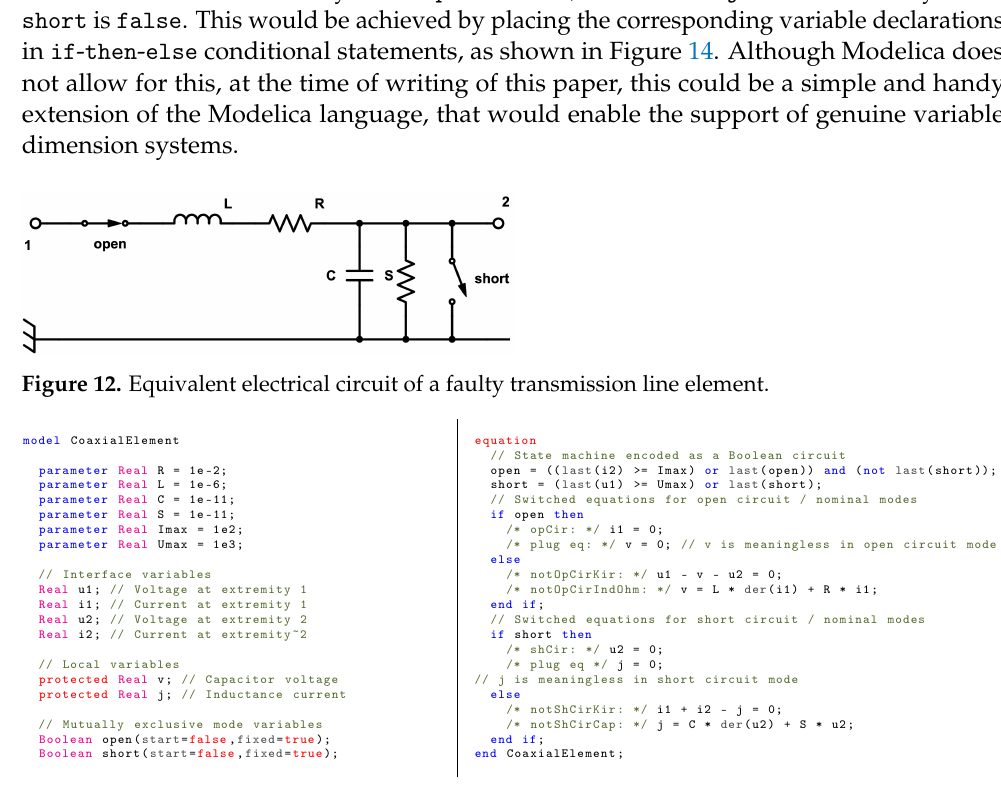
Figure 13. Modelica model of the faulty transmission line